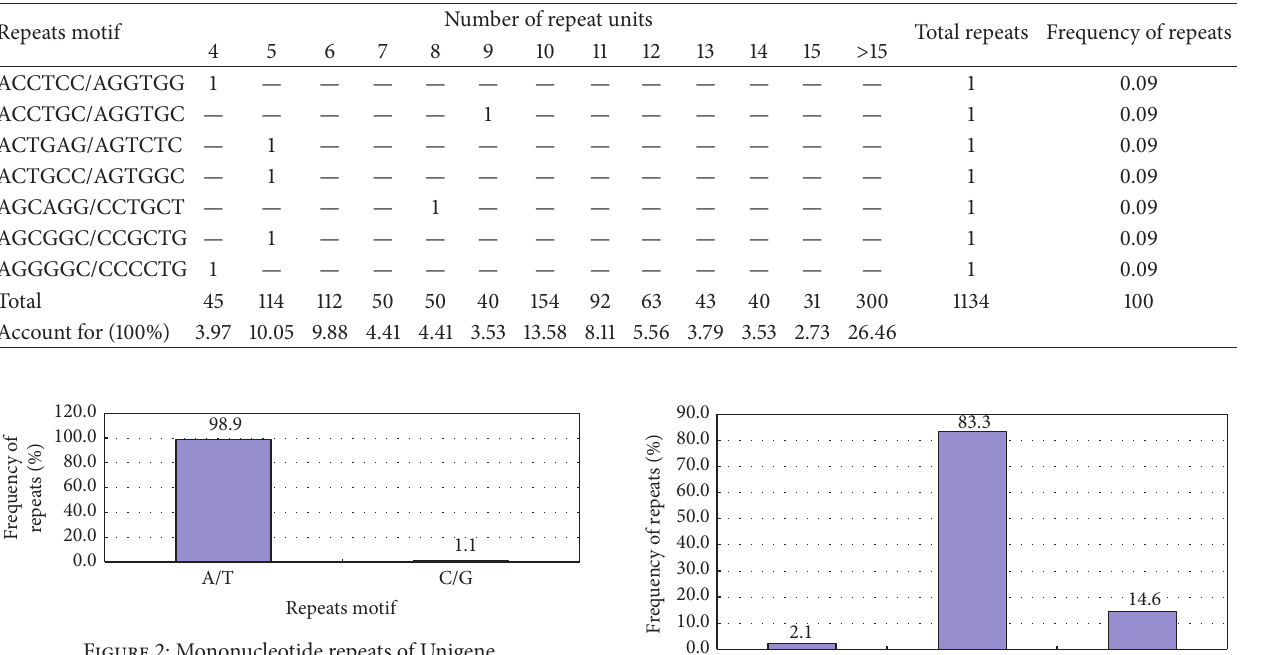
Figure 2: Mononucleotide repeats of Unigene.